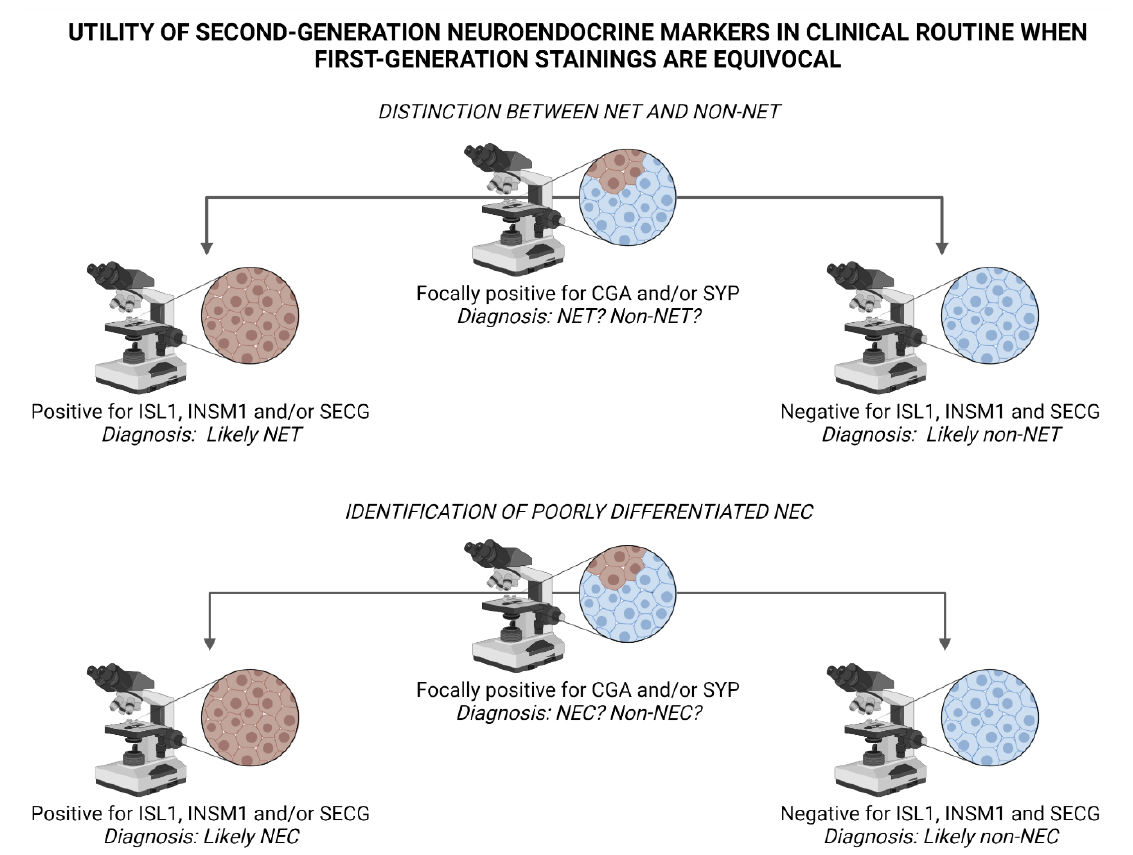
Figure 4. Suggested algorithm for interpreting staining outcomes of second-generation neuroendocrine markers ISL LIM Homeobox 1 (ISL1), INSM Transcriptional Repressor 1 (INSM1) and Secretagogin (SECG) when first-generation markers Chromogranin A (CGA) and Synaptophysin (SYP) are equivocal. Top panel: Diffuse positivity for ISL1, INSM1 and/or SECG indicate neuroendocrine differentiation, and could therefore argue in favor of a neuroendocrine tumor (NET) and help rule out the occurrence of a non-neuroendocrine tumor (non-NET) with focal neuroendocrine differentiation, for example adenocarcinoma, squamous cell carcinoma, malignant melanoma or sarcoma. Bottom panel: Similarly, a positive outcome when staining second-generation markers in poorly differentiated carcinomas may indicate a neuroendocrine carcinoma (NEC) as opposed to a non-neuroendocrine carcinoma (non-NEC). Image created using BioRender.com.